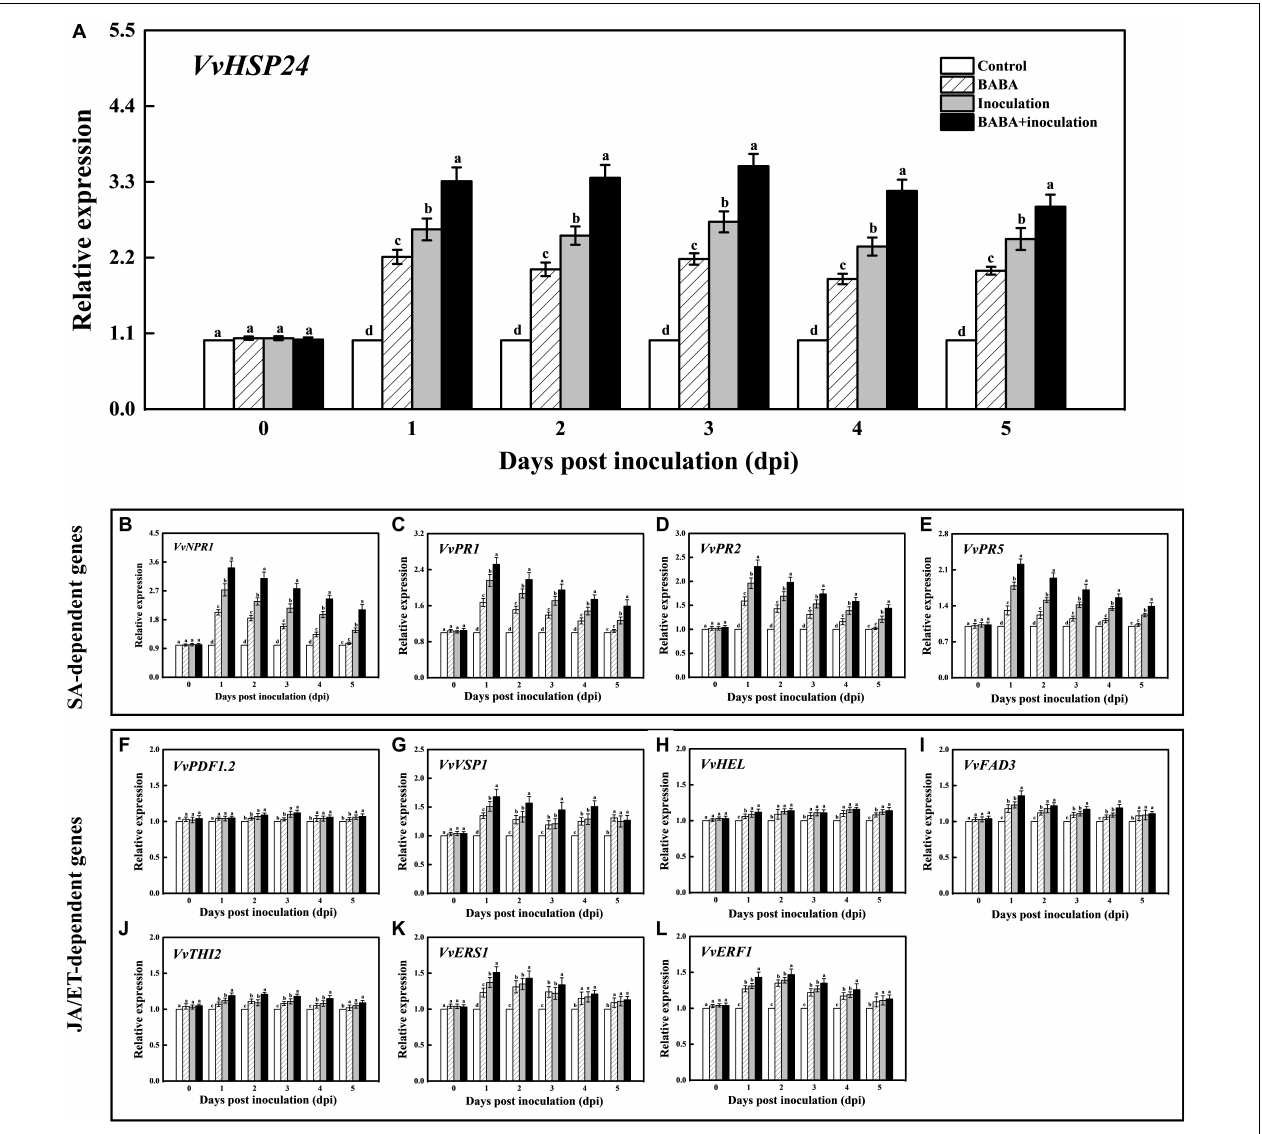
FIGURE 3 | Transcript levels of VvHSP24 (A) , SA-dependent VvNPR1 (B) , VvPR1 (C) , VvPR2 (D) and VvPR5 (E) genes and JA/ET-dependent VvPDF1.2 (F) , VvVSP1 (G) , VvHEL (H) , VvFAD3 (I) , VvTHI2 (J) , VvERS1 (K), and VvERF1 (L) genes in grapes after inoculation with B. cinerea for 1-day intervals. Relative mRNA expression levels are expressed as the mean ± SE. Different letters above the bar represent a significant difference between treatments ( p =